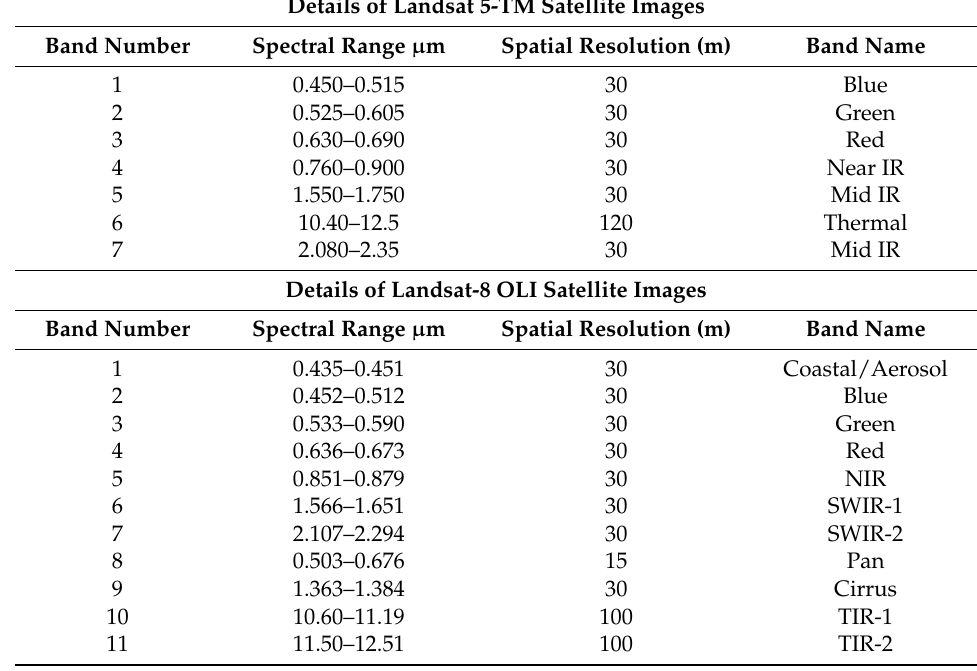
Table 1. Details of Landsat satellite